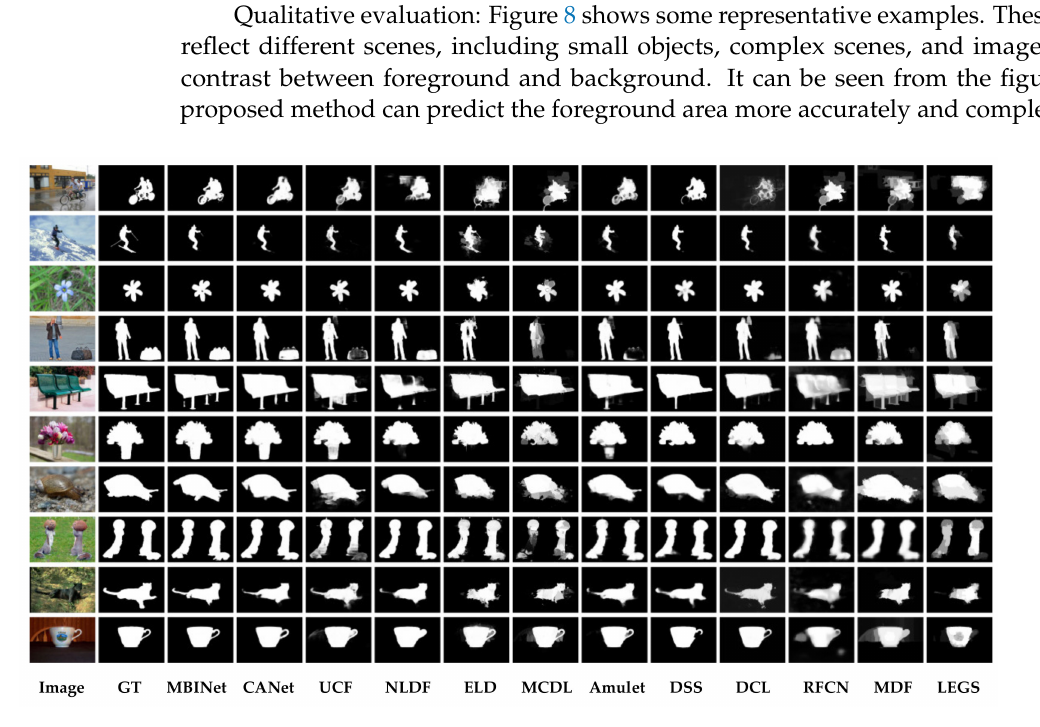
Figure 8. Visual comparisons of different